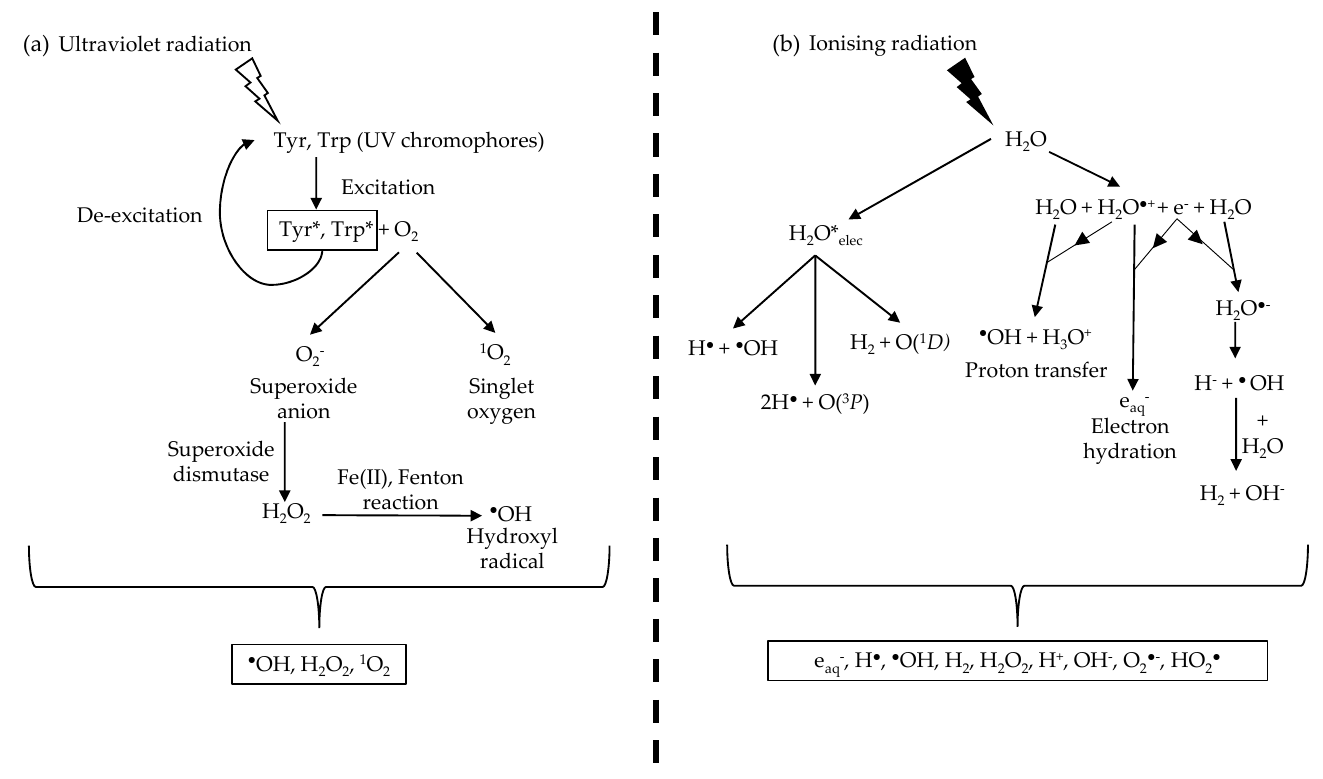
Figure 2. UVR and ionising radiation indirectly damage biological molecules by ROS production. ( a ) UVR produces ROS through UV chromophores that absorb UVR and undergo excitation. The excited chromophores react with oxygen molecules to form singlet oxygen and the superoxide anion. The superoxide anion is converted to hydrogen peroxide by superoxide dismutase before undergoing the Fenton reaction in the presence of Fe (II) to form the hydroxyl radical. ( b ) Ionising radiation produces a range of ROS and, more crucially, the hydroxyl radical through water radiolysis. This results in a larger concentration of hydroxyl radicals produced during ionising radiation irradiation compared to UVR due to the abundance of water molecules. Information from Figure ( b ) was sourced from Meesungnoen J. et al. [57].